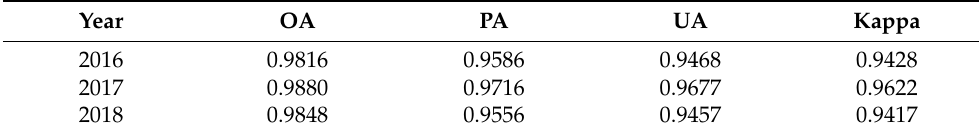
Table 2. Accuracy evaluation indices of SGLs from 2016 to 2018.